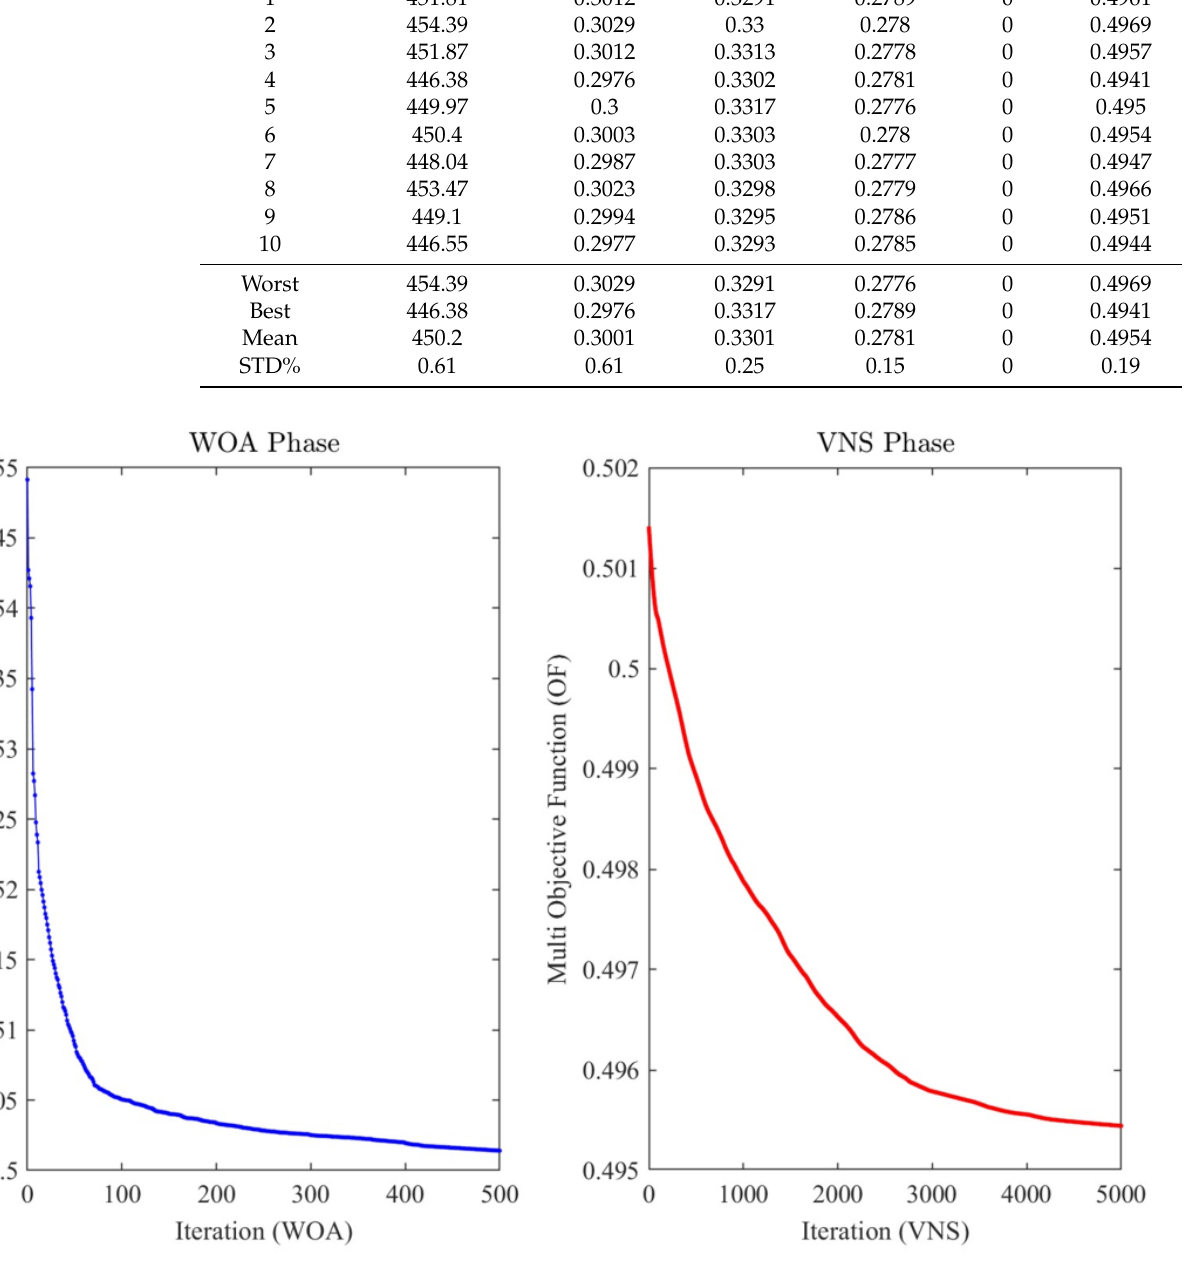
Figure 6. Best OF versus iteration in WOA and VNS phases: WOA phase ( left ), VNS phase ( right ).